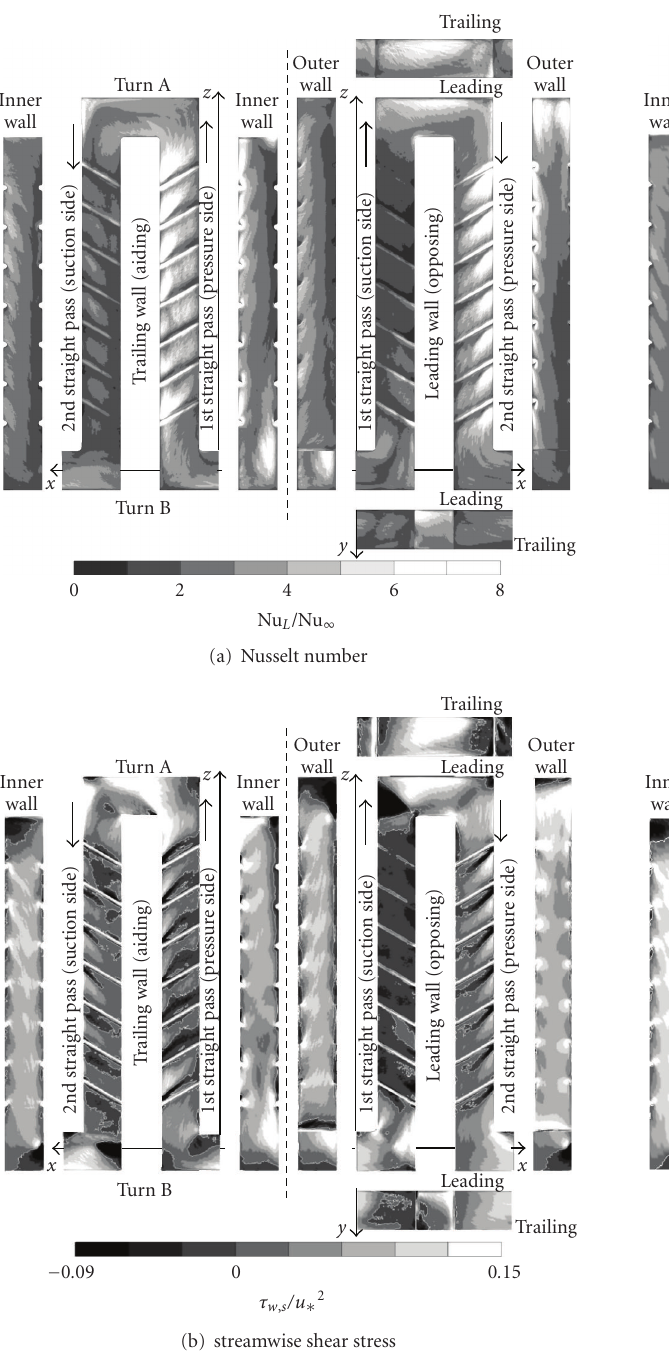
Figure 7: Time-averaged profiles of Nusselt number and stream- wise component of wall shear stress (60 ◦ rib NP, Re ∗ = 1000, Ro ∗ = 1, and Ra ∗ = 2 × 10 4